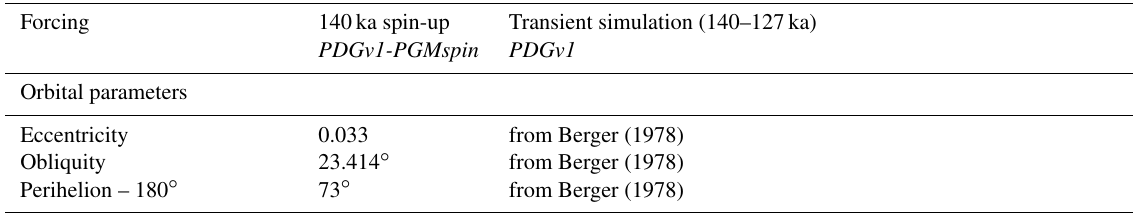
Table 1. Summary of forcings and boundary conditions to apply for the PGM spin-up (140ka) and subsequent transient simulation of the